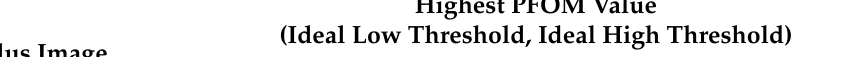
Table 2. Highest PFOM value for grayscale image, extracted green channel of image, and CLAHE on extracted green channel of